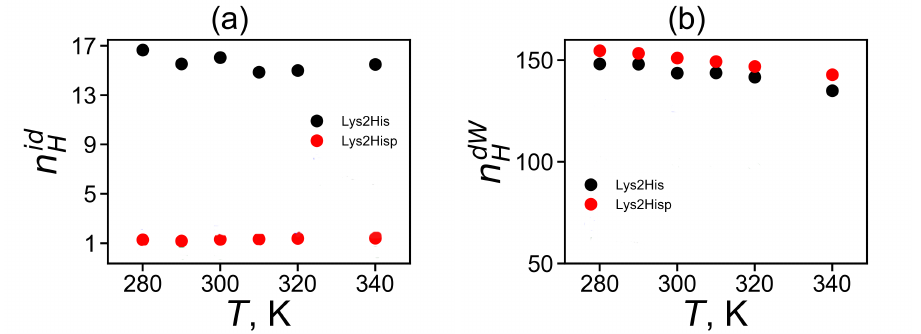
Figure 8. The average number of of ( a ) for intra-dendrimer and ( b ) for dendrimer-water hydrogen bonds as a function of temperature for Lys-2His and